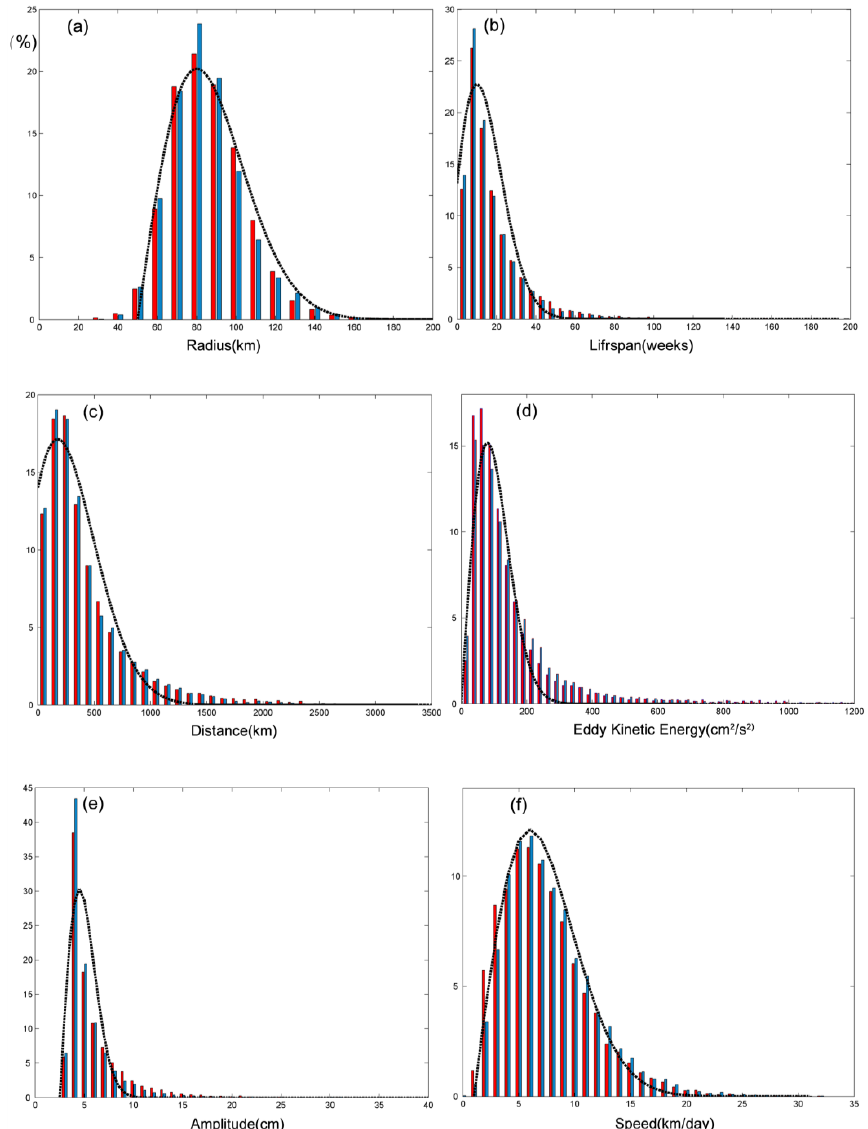
Figure 3. Histogram of eddy radius ( a ); lifespan ( b ); travel distance ( c ); eddy kinetic energy (EKE) ( d ); amplitude ( e ); and speed ( f ). Red and blue bars stand for anticyclonic and cyclonic eddies, respectively. The dotted line is the fitting line of a Rayleigh